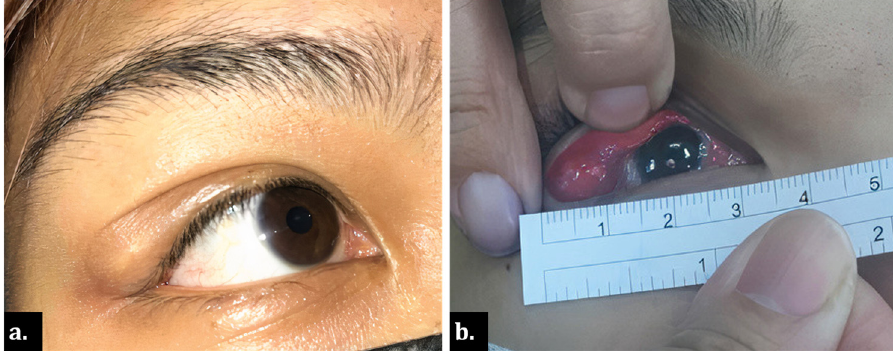
Figure 1. Clinical photograph. ( a ) Yellowish nodule at right upper eyelid appeared as chalazion; ( b ) bulging orbital mass overlaying lacrimal gland, measuring up to 12 mm in diameter.